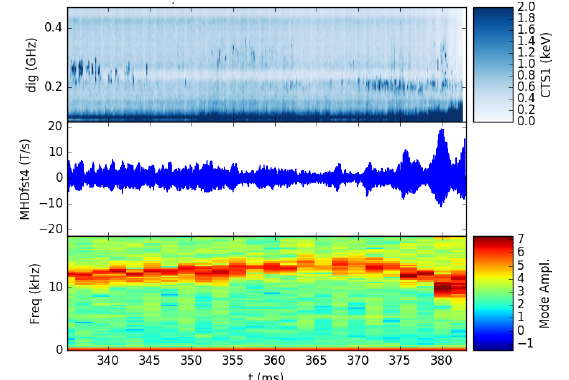
Fig. 7. Frequency spectrum of the emission amplitude in time, with the frequency of the Mirnov coil (black line) superimposed, showing a correlation of the variation of the averaged intensity of the emission with the rotation frequency of the island, during the island slowing down, for shot #40753